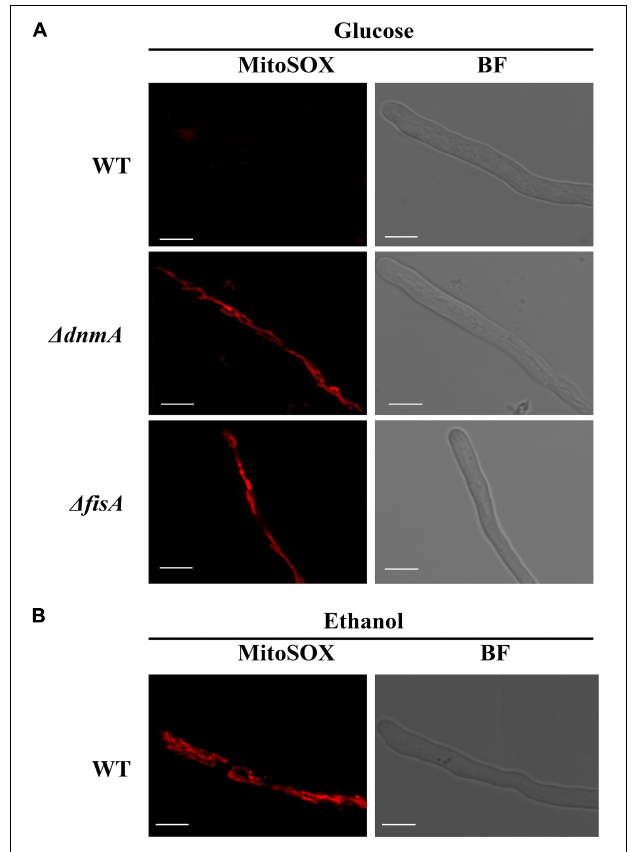
FIGURE 9 | The lack of mitochondrial fission results in increased mitochondrial ROS production. (A) Mycelia from strains A1155 (WT), TVG1 ( (cid:49) dnmA ), and TVG2 ( (cid:49) fisA ) grown for 14 h in supplemented glucose minimal medium were treated with MitoSOX as indicated in Materials and Methods and then observed by using confocal microscopy. (B) Mycelia from strain A1155 (WT) grown for 14 h in supplemented 1% ethanol minimal medium was treated with MitoSOX as before and observed by using confocal microscopy. BF, bright field. White bars = 5 µ